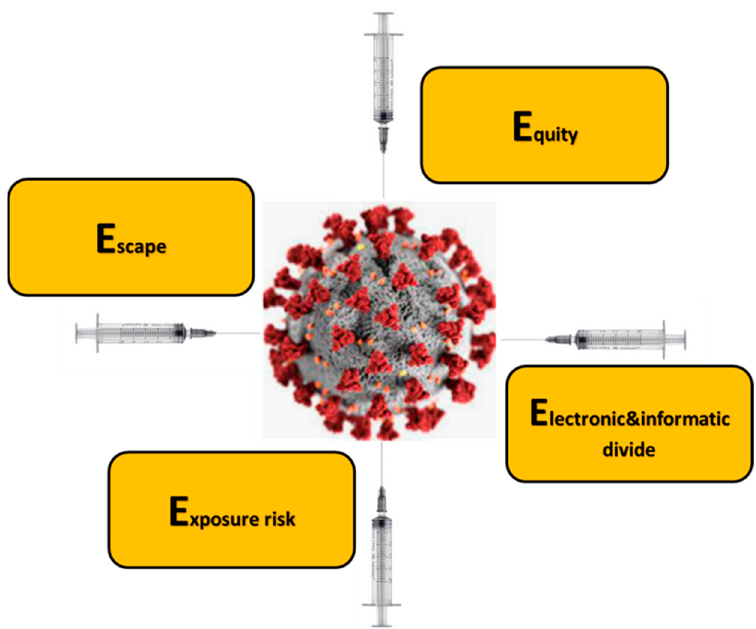
Figure 1. The problems hampering the COVID-19 vaccination process, as identified in our opinion piece.